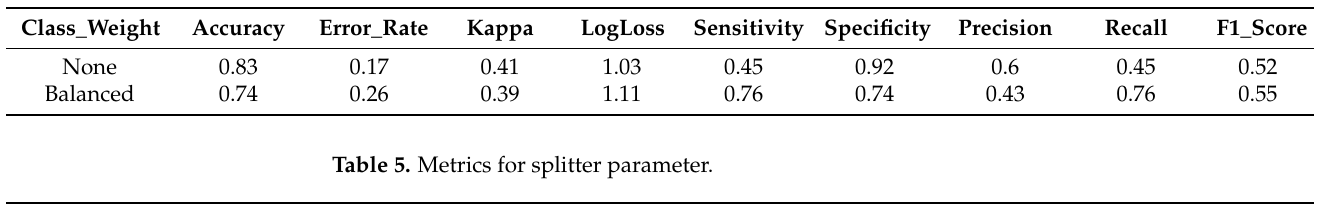
Table 4. Metrics for class_weight parameter.